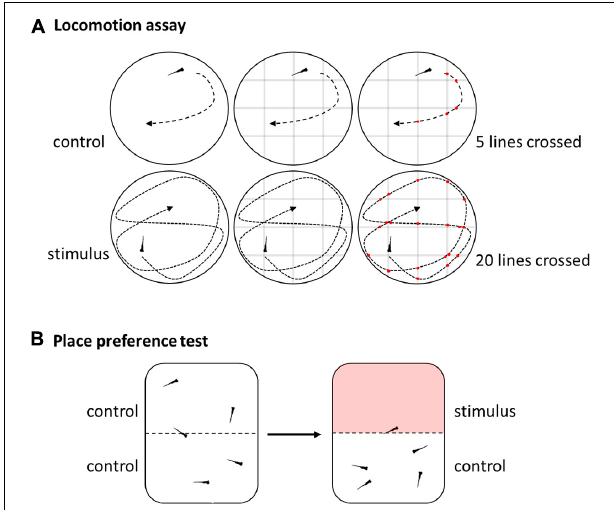
FIGURE 3 | Schematic overview of selected behavioral methods. (A) Locomotion assay used to assess swimming activity by video tracking and either software analysis or by manually counting numbers of lines crossed of a grid digitally overlaid with the movie. (B) Place preference test by video analysis of reactions to aversive or noxious stimuli like heat in a dual heating